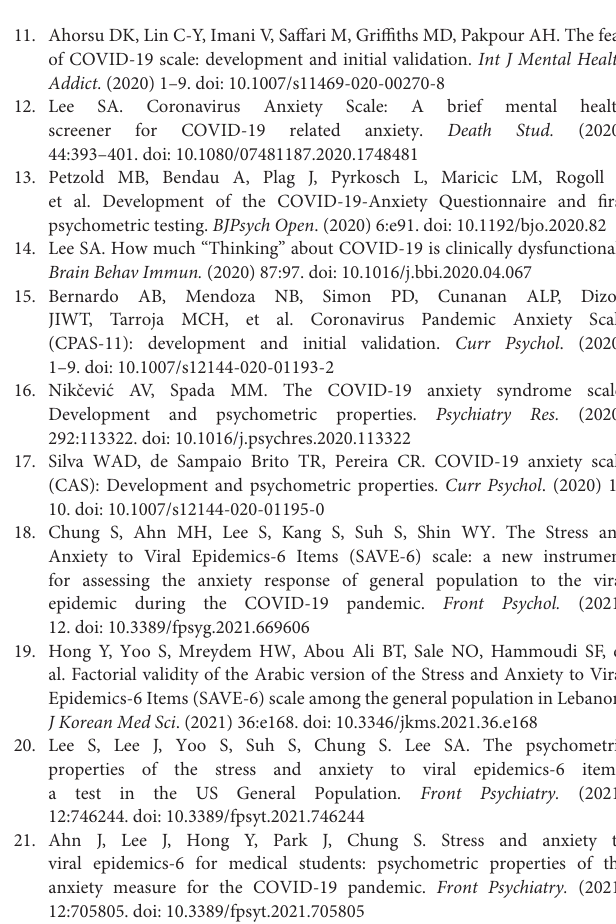
Supplementary Figure 1 | Scale information curve of the French–Canadian version of the SAVE-6 scale. Supplementary Figure 2 | Item response category characteristic curve for each item of the French–Canadian version SAVE-6 scale. Supplementary Table 1 | Local dependence G2 p-values, and slope and threshold parameters of the graded response model. Supplementary Table 2 | Monotonicity and item fit results of the French-Canadian version of the